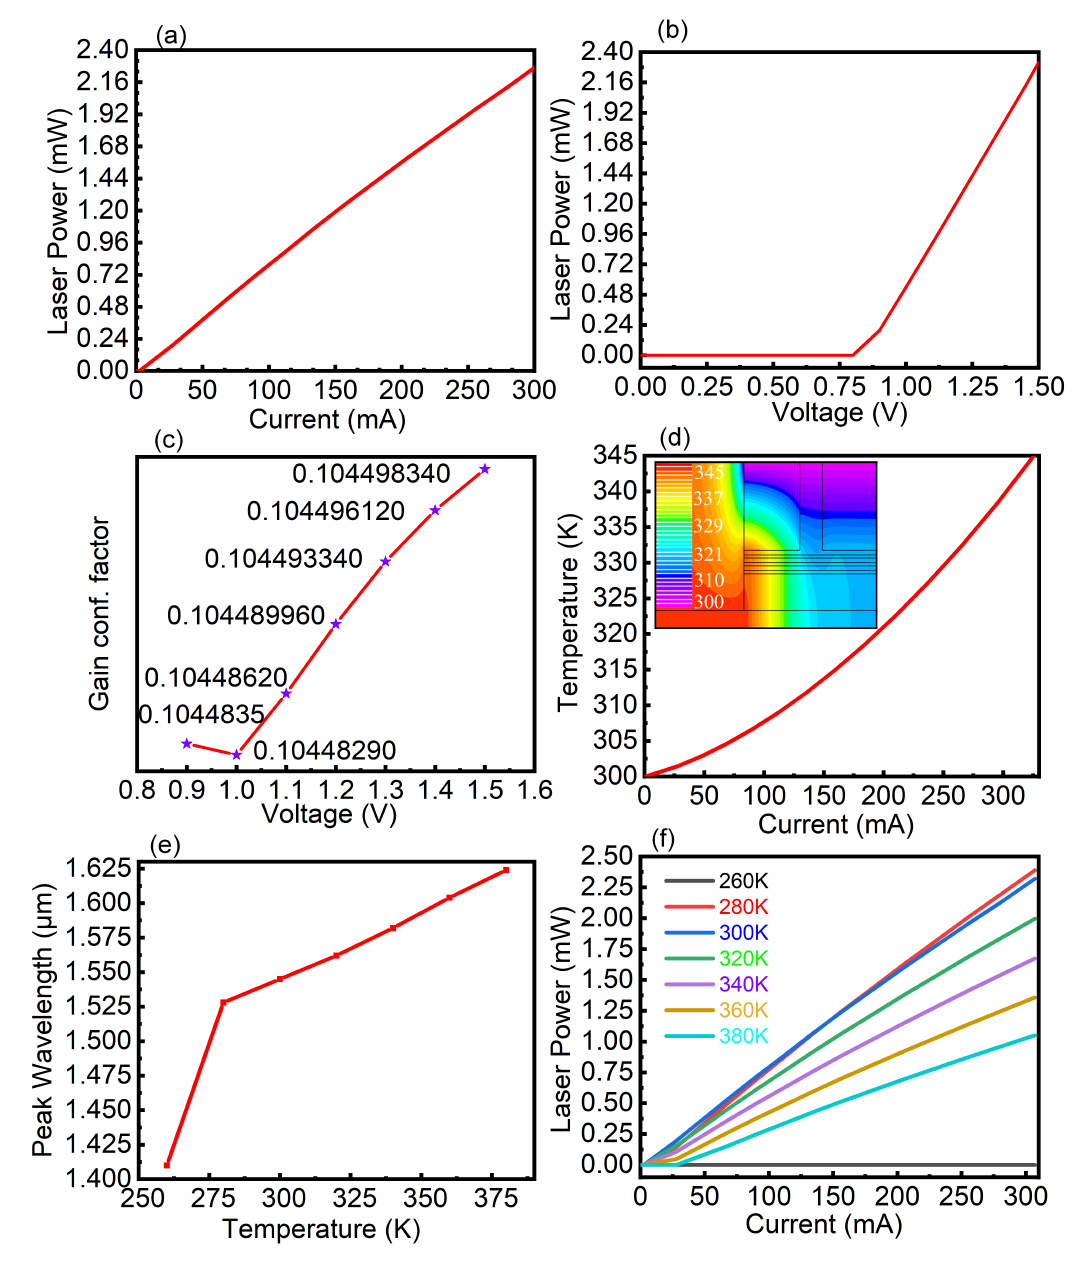
Figure 4. ( a ) The relationship between the laser current and laser power. ( b ) The relationship between the laser voltage and laser power. ( c ) The diagram of laser gain confinement factor. ( d ) The temperature change for different currents. ( e ) The temperature change for different peak wavelengths. ( f ) The luminous power diagram for different